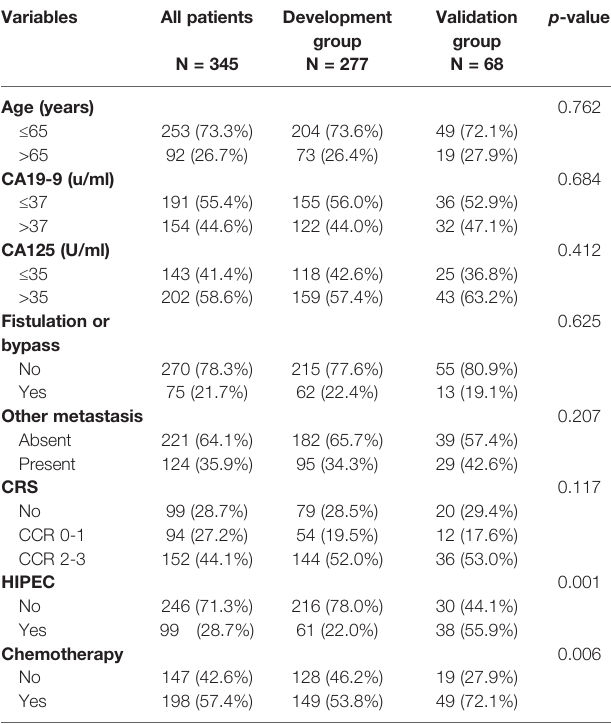
TABLE 1 | A part of characteristics of CRC patients with S-PM in the development and validation groups.